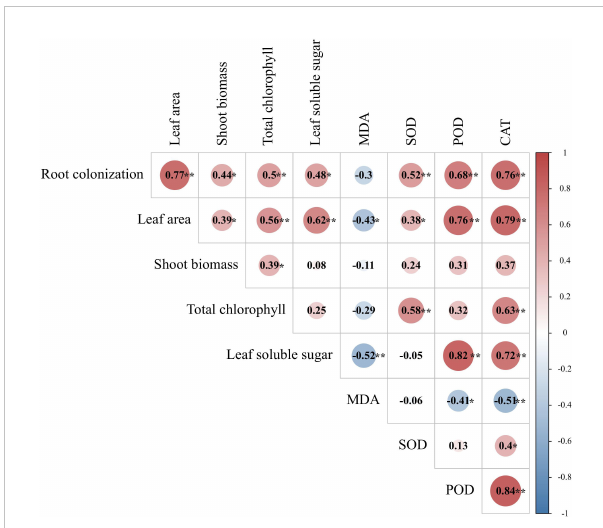
FIGURE 8 Correlation heat map between AMFs colonization and leaf-related indicators. **Signi fi cant at p < 0.01; *signi fi cant at p <